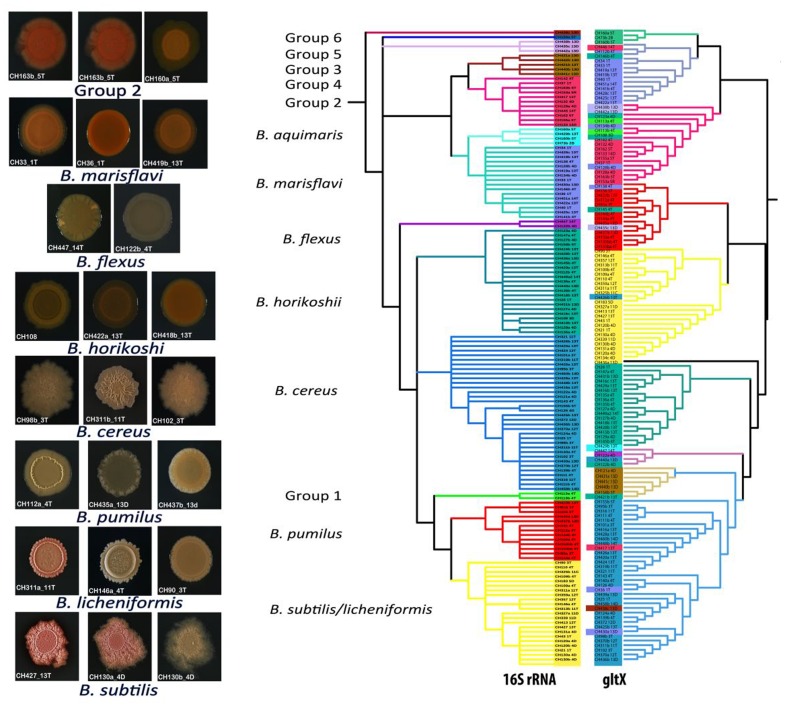
Distinct colony morphology of members of different Bacillus taxonomic groups and comparison between 16S rRNA gene and gltX gene phylogenies. The colored rectangles indicate strains that have moved within the phylogenetic group in the tree of 16S rRNA genes with respect to the gltX gene. On the left side of the figure, photographs of colonies of strains belonging to the same taxonomic clade.